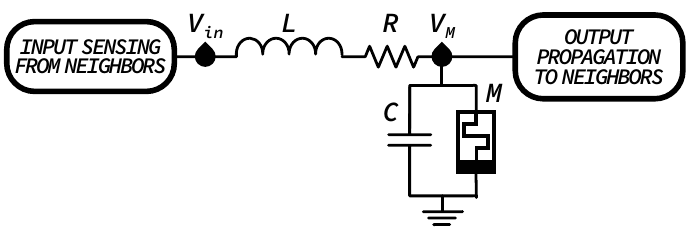
Figure 14. MemCA cell circuit